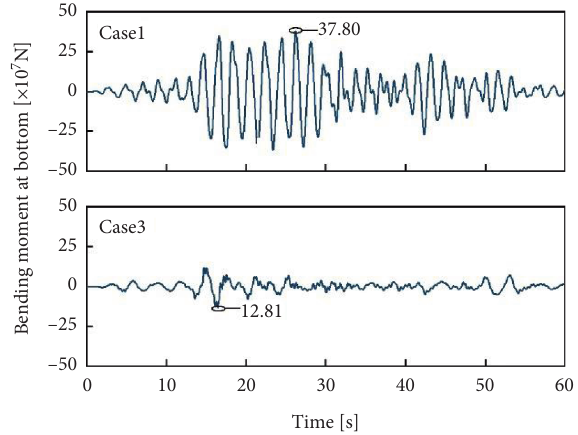
Figure 11: Bending moment time histories of pier No. 4 in Cases 1 and